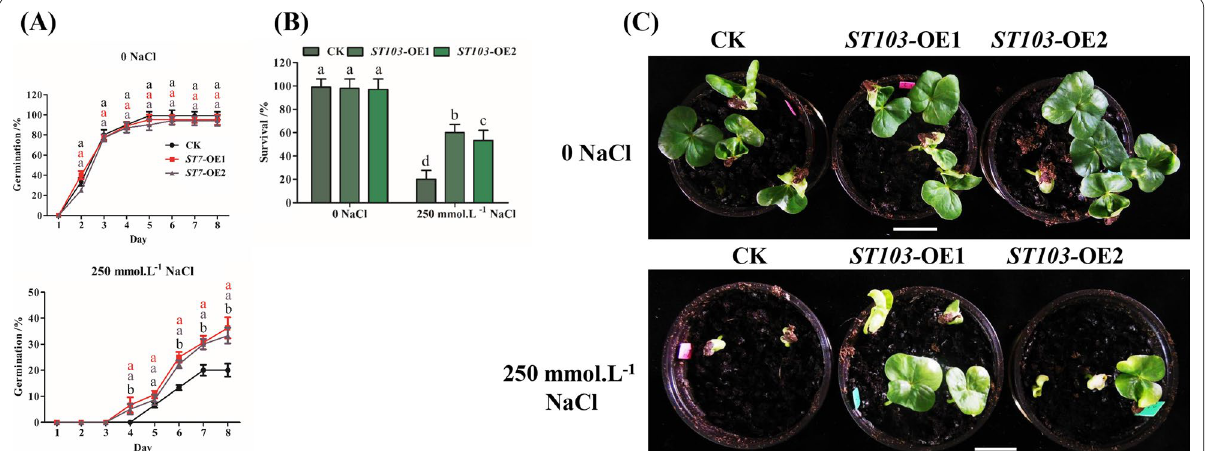
Fig. 1 ThST103 confers salt tolerance phenotype in seed germination in cotton. A Curve of seed germination. The seeds overexpressing ThST103 genes and CK were germinated for 8 days in the soil augmented with 0 and 250 mmol L − 1 NaCl and the germination rate was recorded daily. · Values are mean SD (10 seeds per replicate, five replicates per treatment). Different letters denote significant differences ( P < 0.05) from Duncan’s ± multiple range tests. B Ratio of seedling survival. The germinated seedlings were grown for 2 weeks prior to the recording of seedling survival ratio. Values are mean SD (10 plants per replicate, five replicates per treatment). Different letters denote significant differences ( P < 0.05) from Duncan’s ± multiple range tests. C Growth of germinated seeds. Bar 4 =